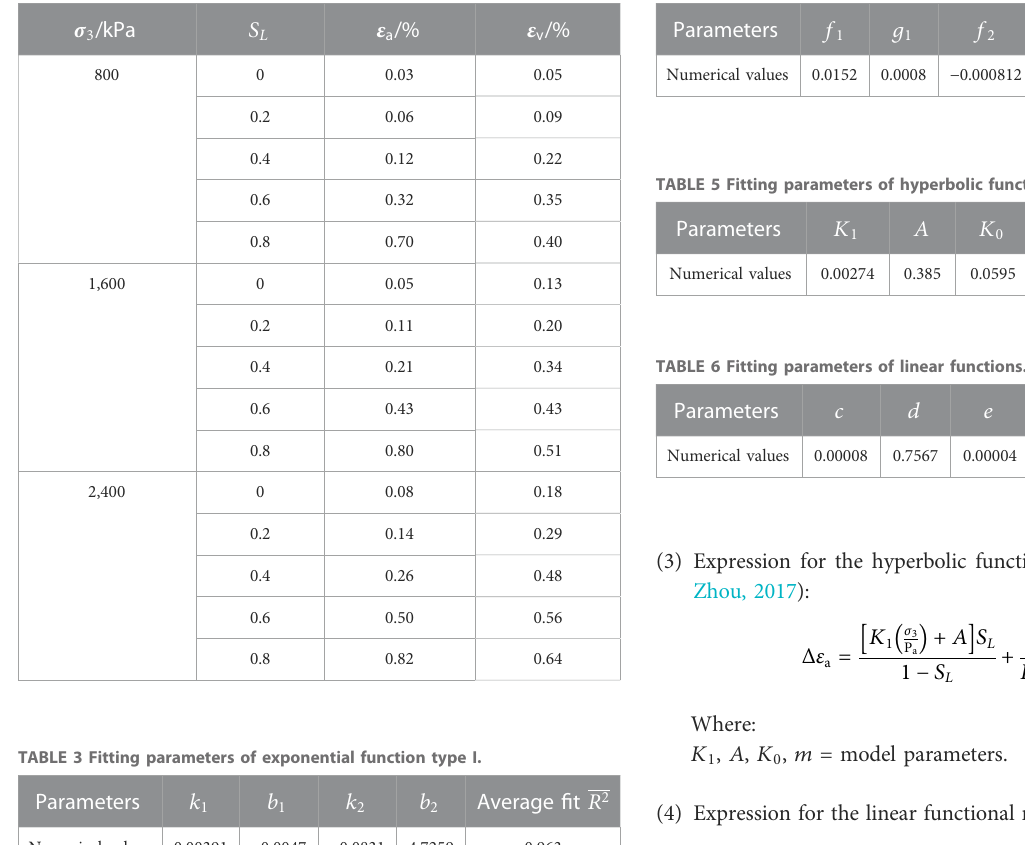
TABLE 2 Wetting deformation of coarse-grained materials.